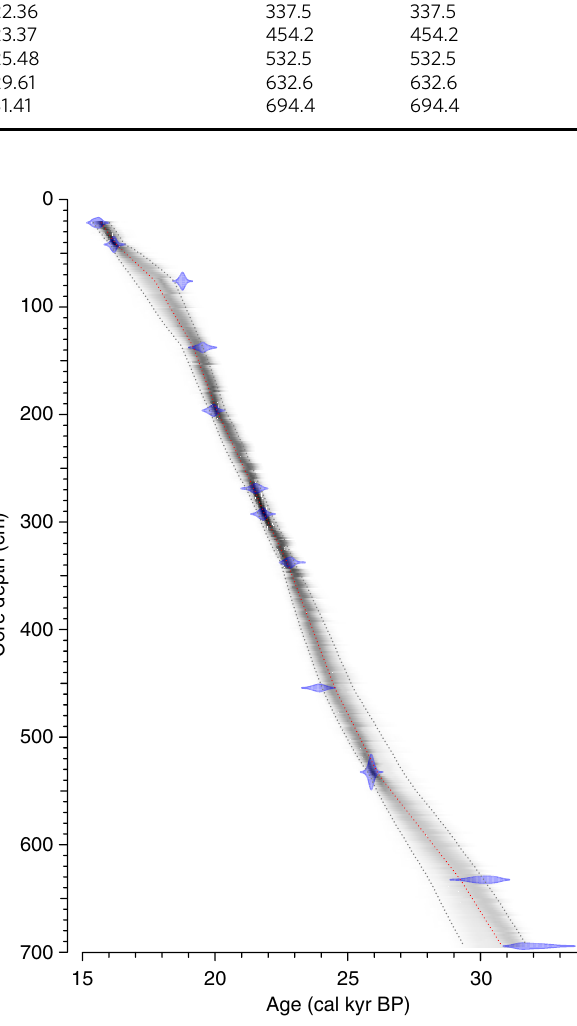
Fig. 4 Age model. Age-depth relationship of the upper 700 cm of sediment core GS14-190-01PC using a Bayesian age modeling (Bacon v2.2) approach 34 on 12 AMS 14 C